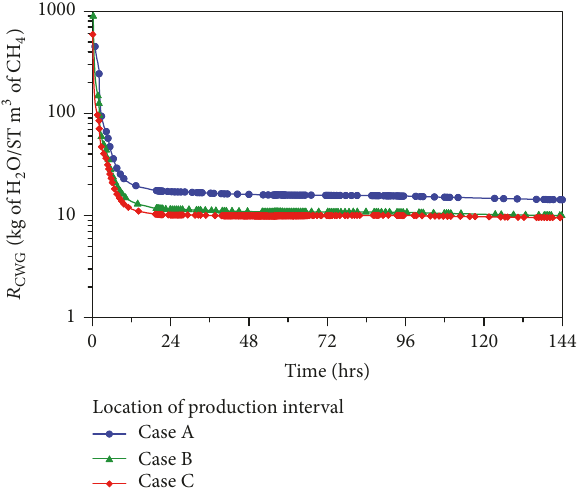
Figure 18: The evolution of simulated 𝑅 CWG during the 6-day production test under different locations of production